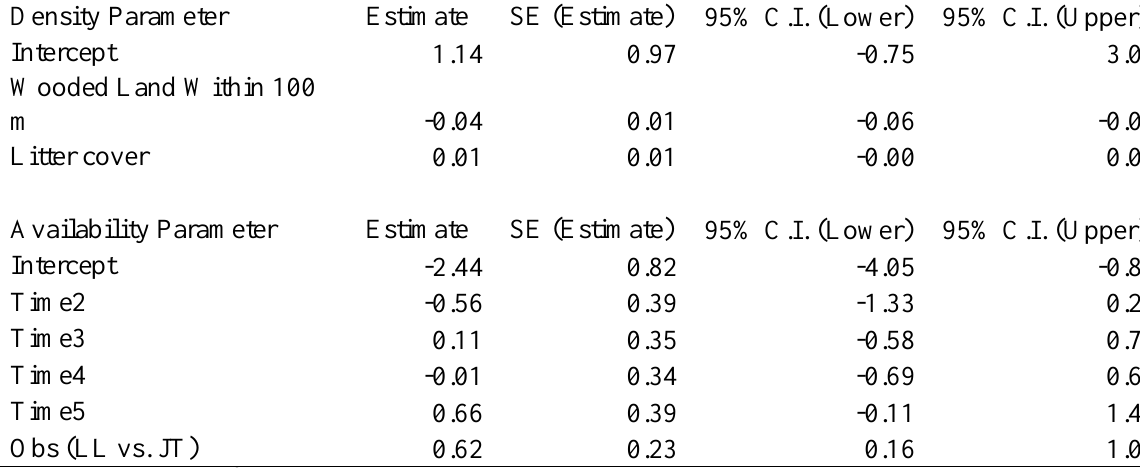
Table A2.H . Highest-ranking hierarchical distance-sampling model (AIC AIC weight=0.20) for Savannah Sparrows along 34 transmission line study sites in Winnipeg, Manitoba, Canada in 2007 (n=102 surveys), assuming a uniform detection probability with increasing distance of birds from the transect line and effects of time of morning and observer experience but not Julian date on availability for